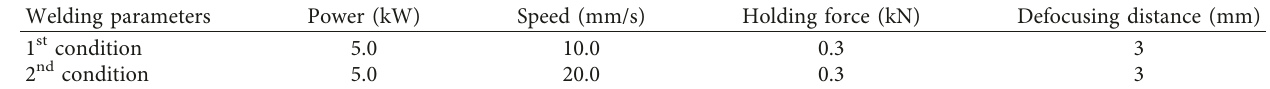
Table 4: The welding